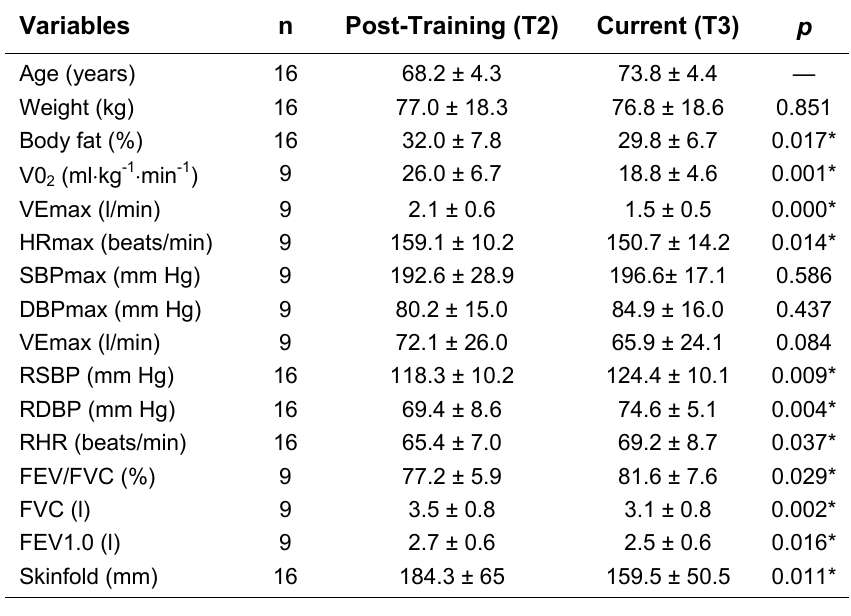
Post-Training and Current Measurements for Sedentary Subjects